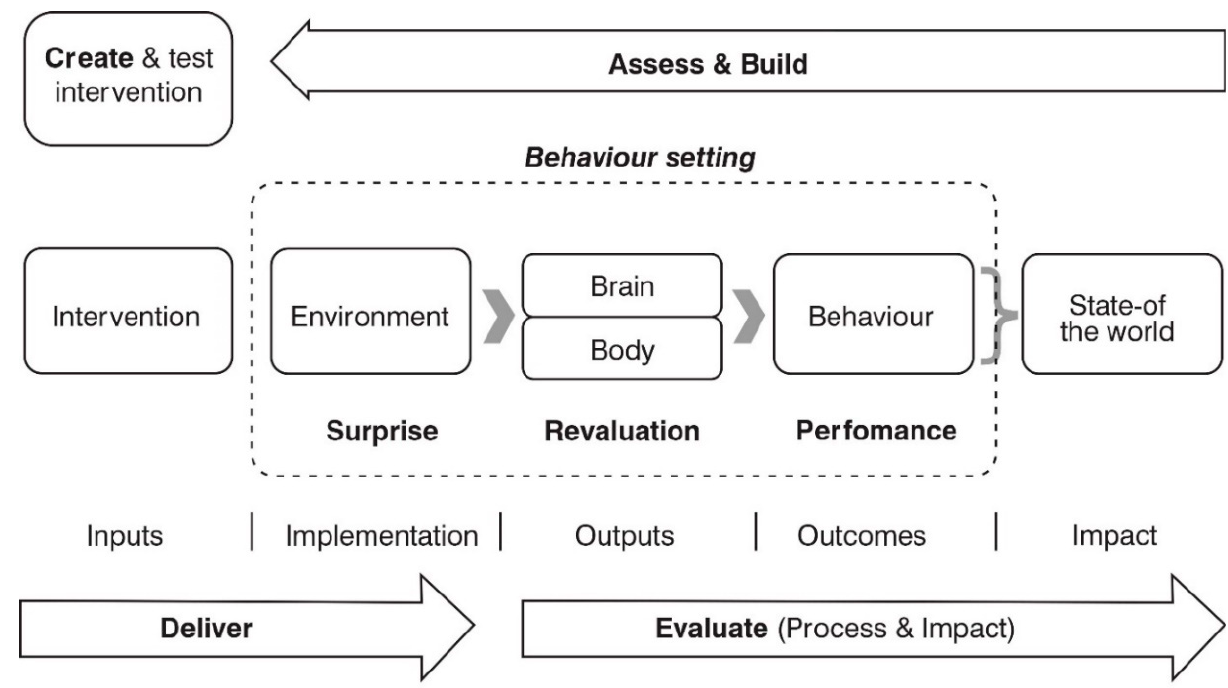
Figure 1. Behavior centered design Model [15].